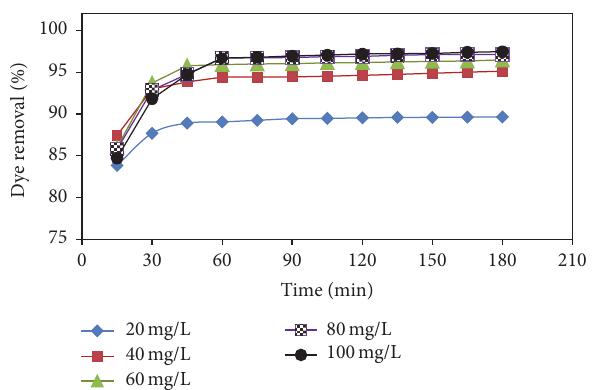
Figure 9: Effect of contact time on the removal of RR-RB dye in the presence of RB-5 dye (binary system) (temp. = 25 ∘ C, speed = 200 rpm, dose = 0.1 g/100mL, and con. of RR-RB = con. of RB-5).